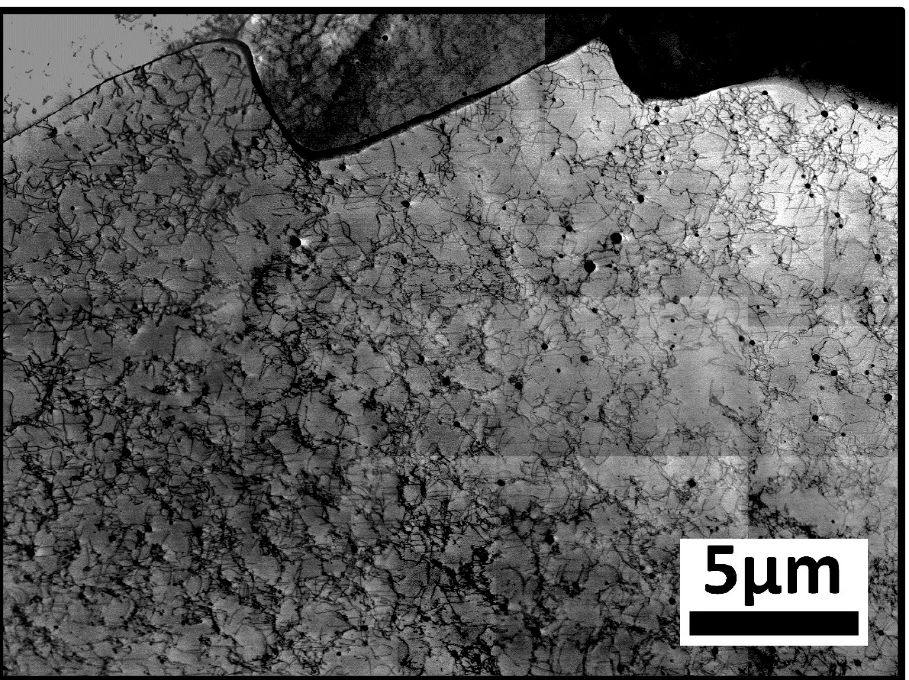
Figure 6. TEM micrograph showing the dislocation structure in massive ferrite in Steel A.